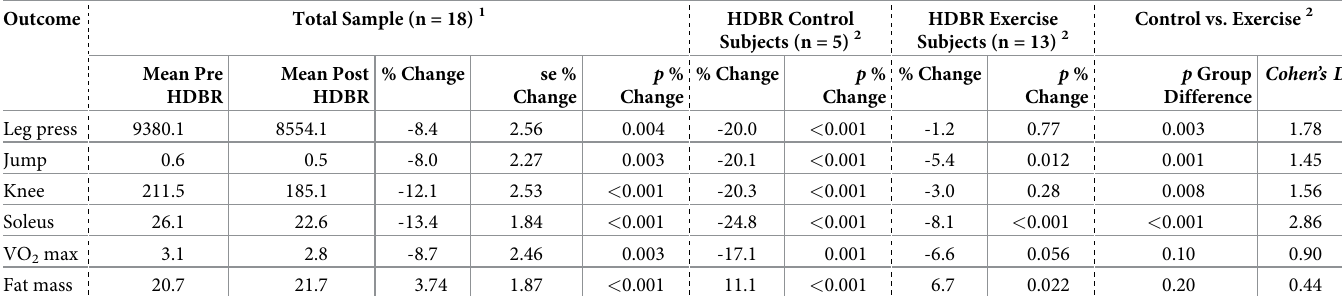
Table 1. Physical fitness changes with bed rest.